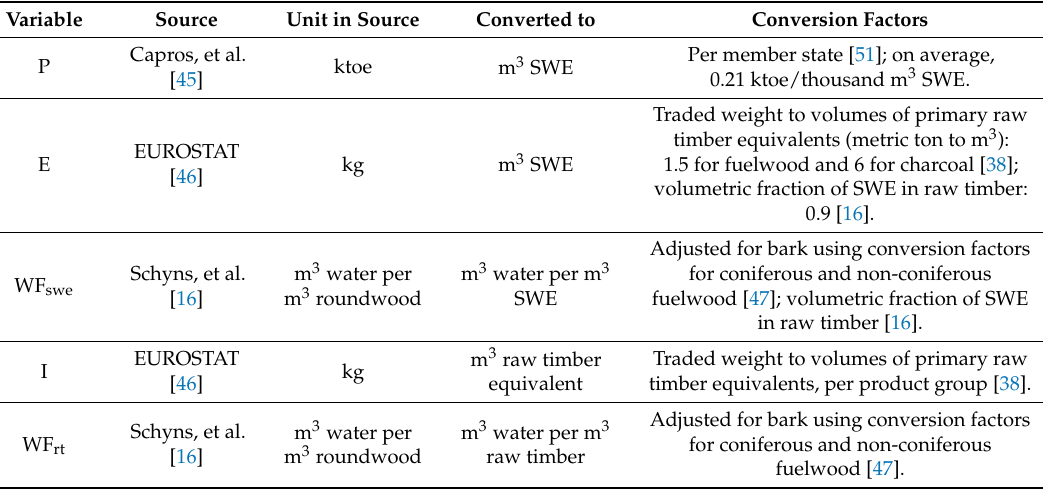
Table 1. Data sources and applied conversions to estimate the water footprint (WF) of wood for energy consumed in the European Union (EU) according to Equation